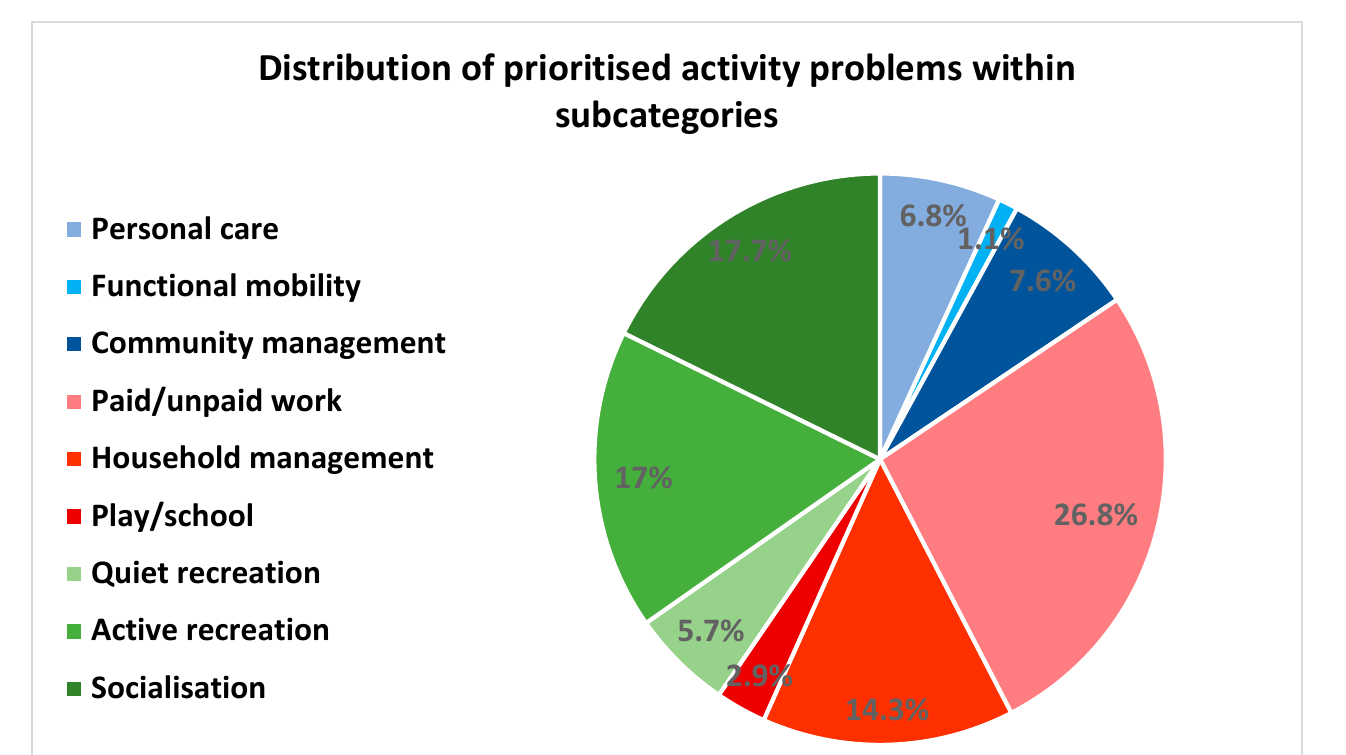
Figure 6. Distribution of activity problems (%) within the COPM subcategories: self-care (blue) com- prising personal care, functional mobility and community management; productive activities (red) comprising paid/unpaid work, household management and play/school; leisure activities (green) comprising quiet recreation, active recreation and socialisation. COPM data is based on 430 patients.